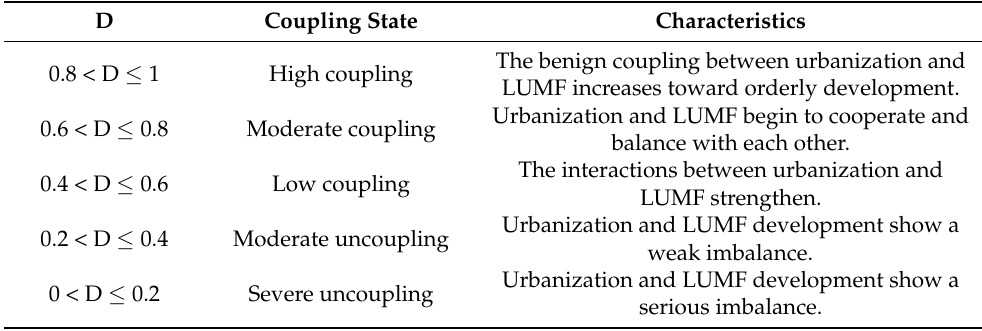
Table 3. Classification of the CCD between urbanization and LUMF.